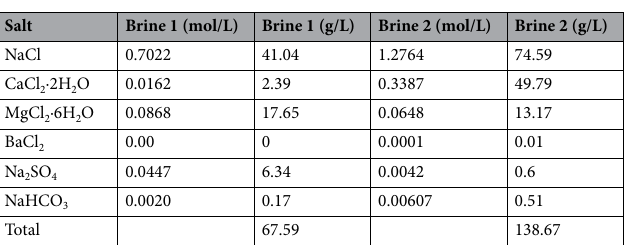
Table 1. Compositions of artificial brines used to prepare surfactant